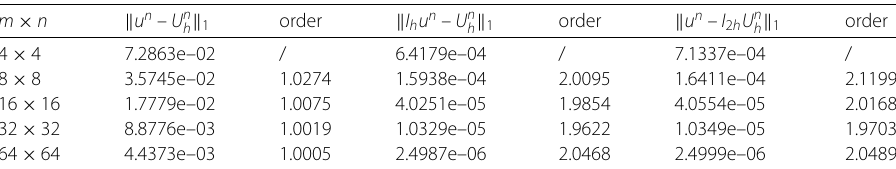
Table 2 Numerical results of u at t = 0.1